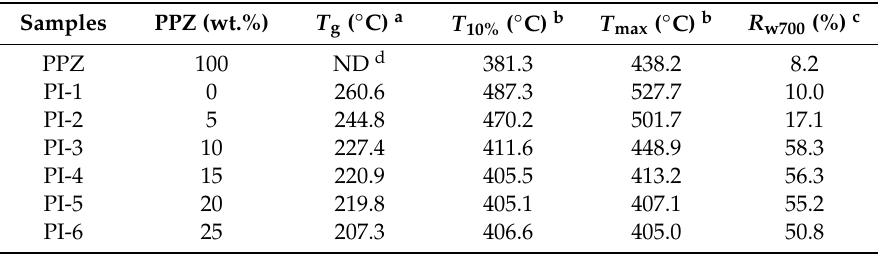
Table 2. Thermal properties of PPZ FR and PI films.